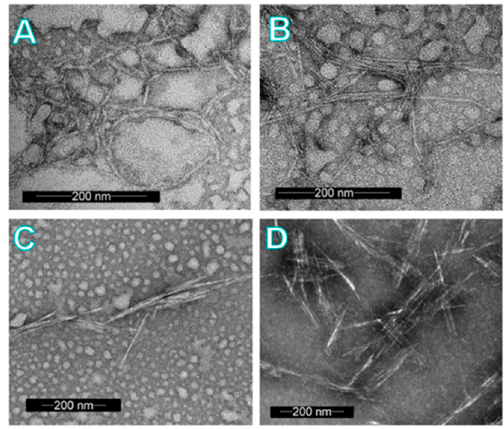
Figure 5. TEM images of the cellulose nanoparticles ( A – D ). Upper figures are representing the CNF samples NON-F-CNF ( A ) and SF-CNF ( B ) while lower figures represent the samples SF-CNC ( C ) and REF-CNC ( D ).